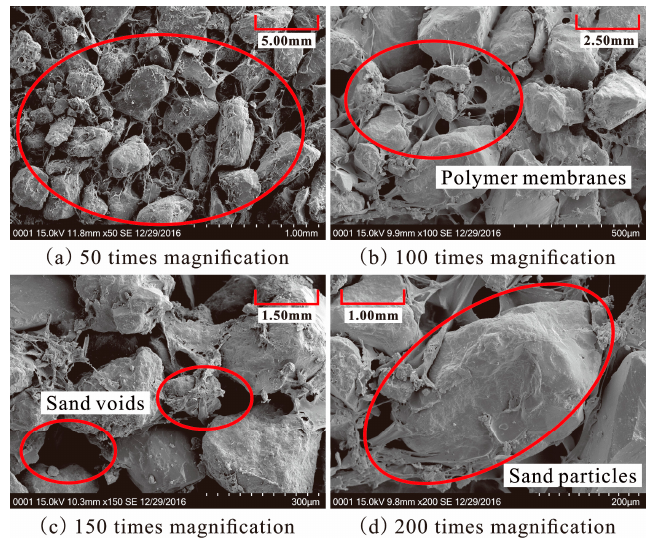
Figure 14. SEM images of specimen reinforced with 50% polymer: ( a ) 50 times magnification; ( b ) 100 times magnification; ( c ) 150 times magnification; ( d ) 200 times magnification.